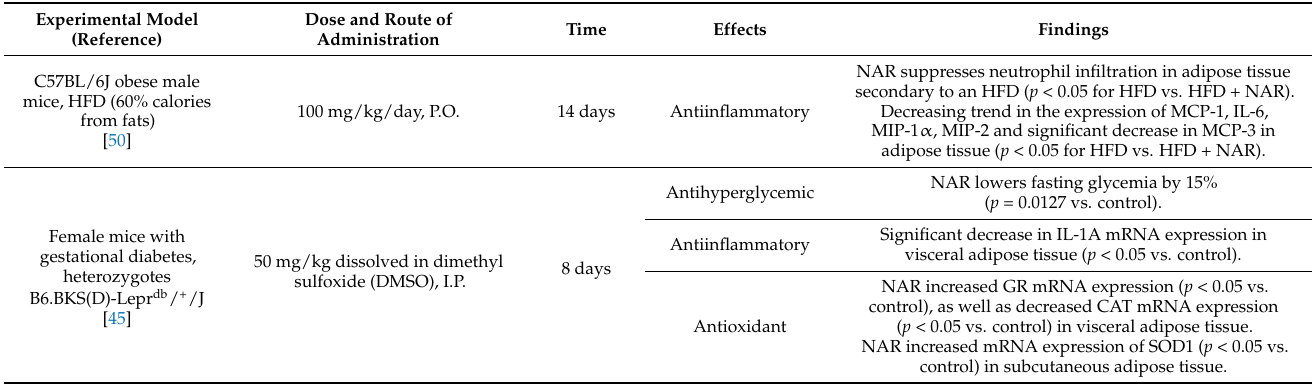
Table 1. Findings from in vivo and in vitro studies evaluating metabolic effects of naringenin (NAR)